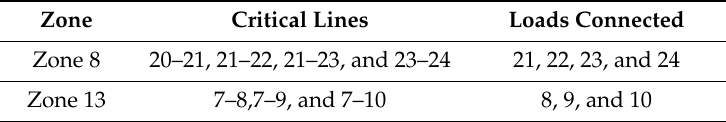
Table 8. Critical zones and critical lines.